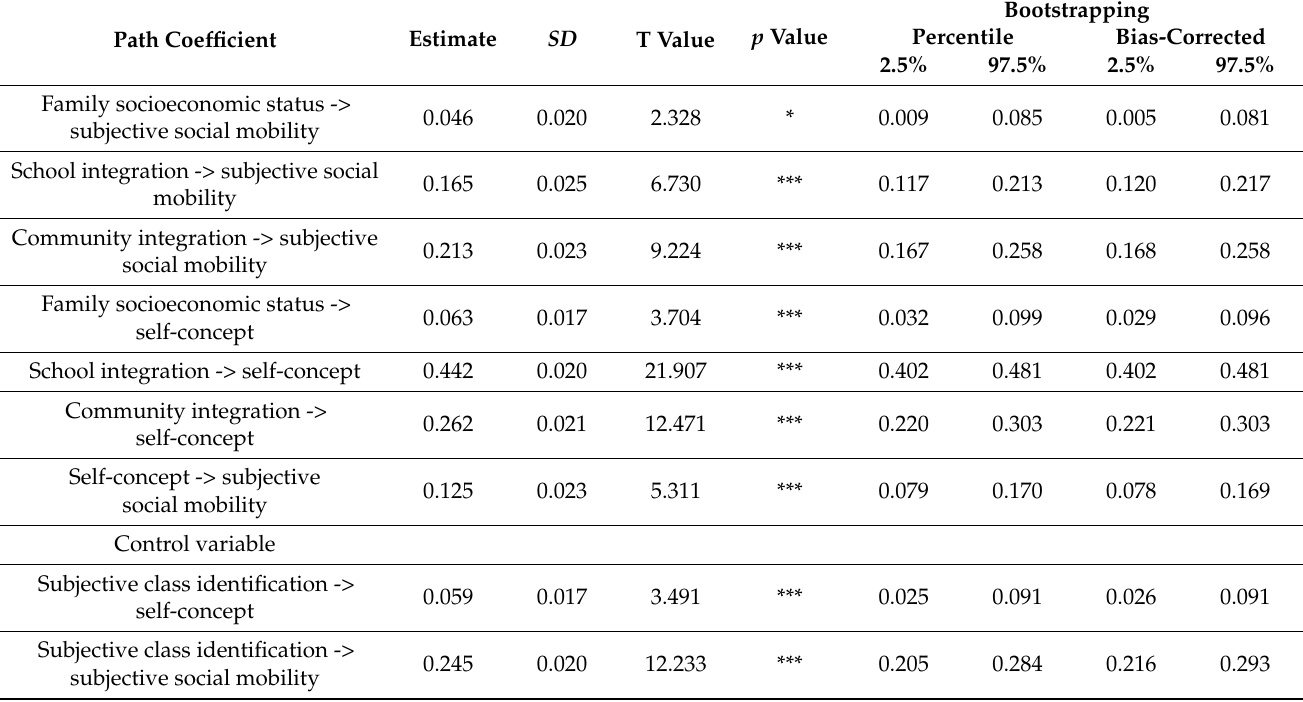
Table 5. Structural model path